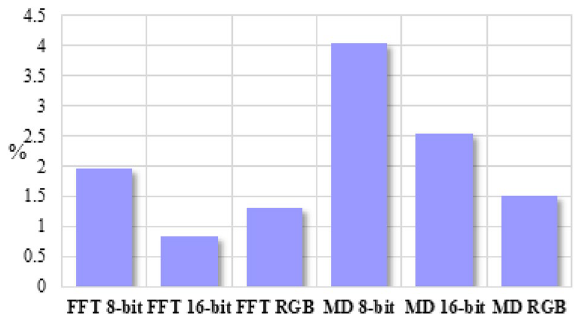
Figure 3. The differences of the ratio between Kolmogorov Complexities for images generated with the Inverse FFT or MD algorithm and Fractal dimension was 2.5 with 8-bit, 16-bit, Red–Green–Blue (RGB) image formats and the lowest resolution (281 × 1000 pixels) and the largest icon (1000 × 1000 pixels). Each bar indicates a ratio between KC and resolution. In all the analyzed situations normalized KC for the smallest and largest analyzed images differed by only 2% in the situation of images generated with Inverse FFT algorithm and up to 4% for images generated with MD algorithm.